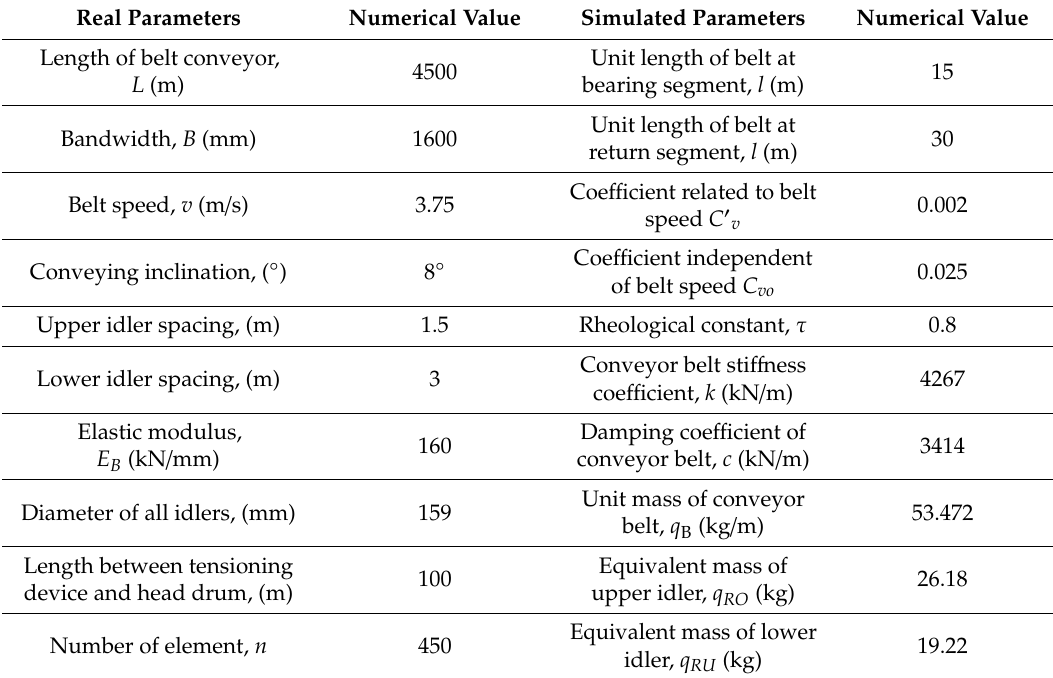
Table 3. Real and simulated parameters of the belt conveyor.